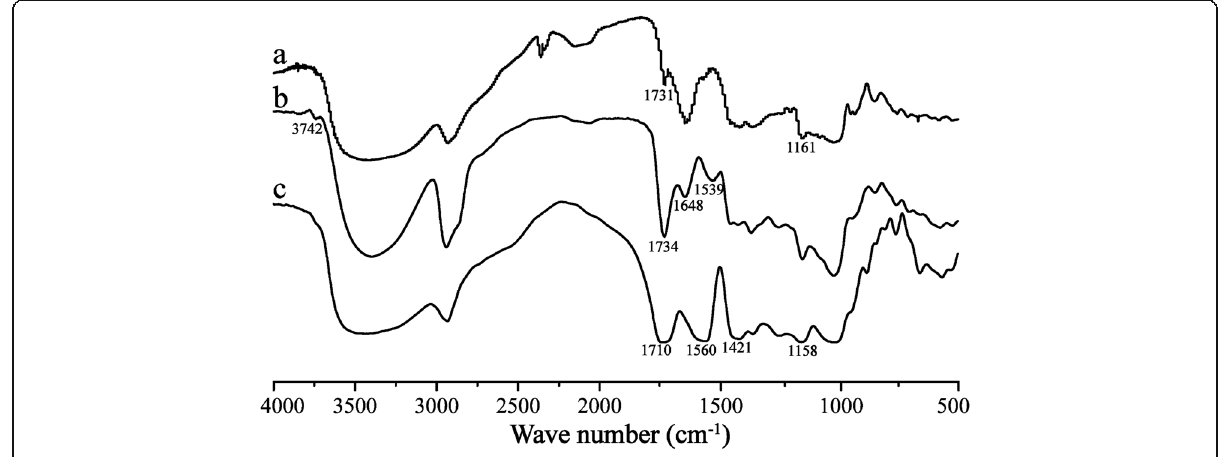
Fig. 2 FTIR spectra of CHP (a), CHAP (b), and CHSP (c)